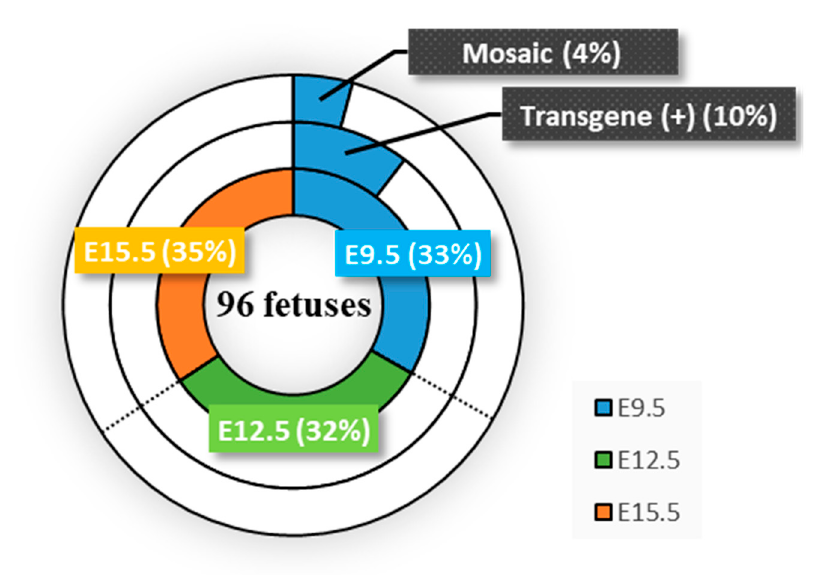
Figure 2. Summary of data on fetuses obtained after hydrodynamics-based gene delivery (HGD)-based transplacental gene delivery for acquiring genome-edited fetuses (TPGD-GEF) at E9.5, E12.5, and E15.5. Blue, green, and orange in the pie chart indicate the data obtained after HGD-based TPGD-GEF at E9.5, E12.5, and E15.5, respectively. A total of 96 fetuses were collected from the experiments and 10% of these fetuses were identified as having the plasmid DNA introduced. Finally, 4% of fetuses obtained exhibited successful genome editing at a target locus, although the mode was mosaic mutations. Notably, fetuses with transgenes and the genome-edited MHC α gene were all derived from HGD-based TPGD-GEF at E9.5.